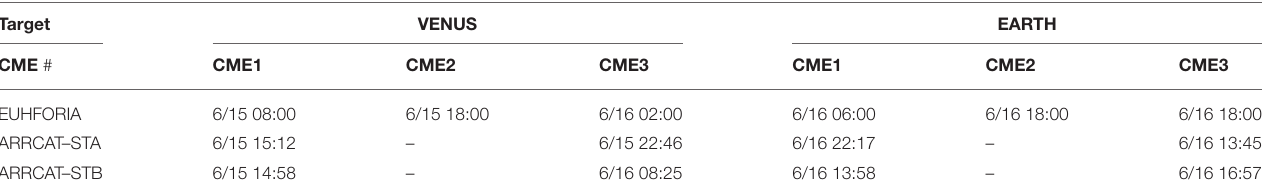
TABLE 2 | Arrival times of the three CMEs at Venus and Earth based on EUHFORIA results and HELCATS/ARRCAT STEREO/SECCHI/HI-A and -B reconstructions. Target VENUS